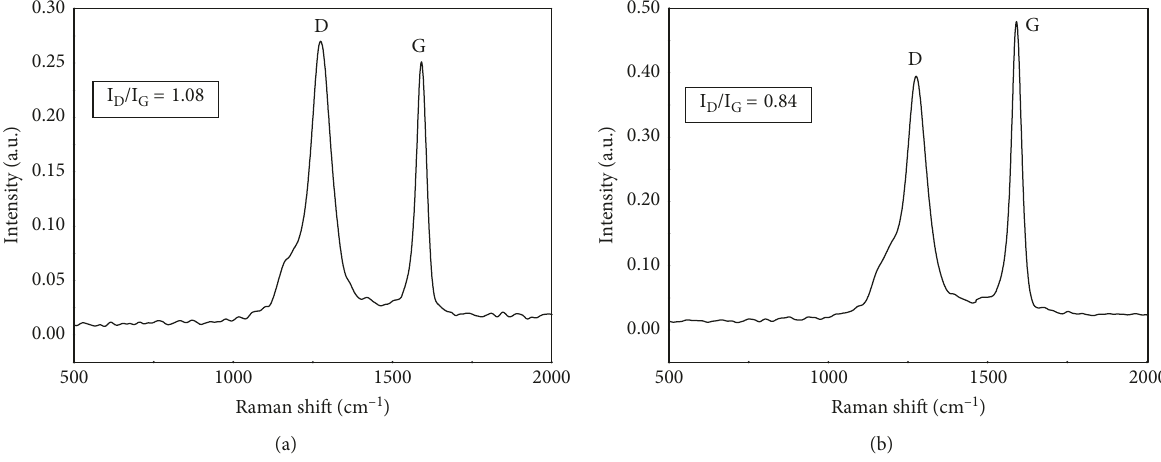
Figure 6: Raman spectra of MWCNTs grown using different growth temperatures of (a) 900 ° C and (b) 950 °